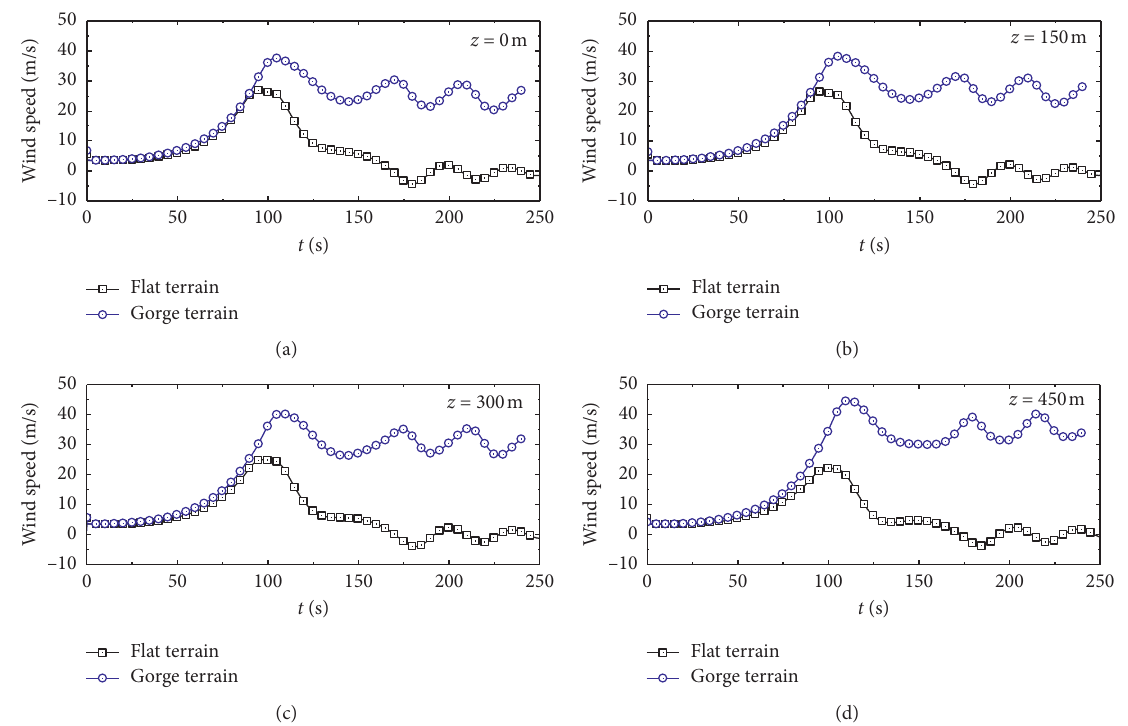
Figure 7: Comparisons of time-history curve of wind speed between the flat terrain and the gorge